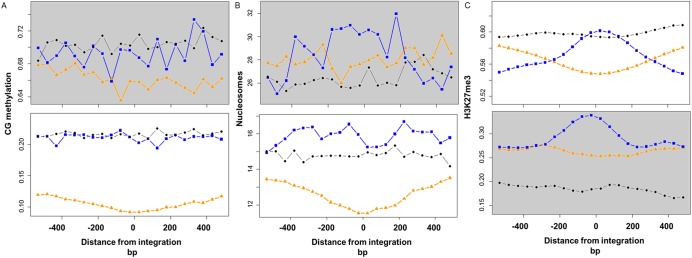
Epigenetic modifications around T-DNA–genome junctions.The analysis was performed separately in pericentric (grey background) and in remaining (distal) chromosomal regions. The up and downstream regions to T-DNA–genome junctions (represented as the 0 bp) are shown on the X axis. The Y axis represents the arbitrary level of the epigenetic markers. Blue squares–unselected T-DNA–genome junctions. Orange triangle–integrations under selective conditions [13]. Black circles–control, random genomic positions.–. A- CG methylation. B–Nucleosome occupancy. C- H3K27me3 modification.